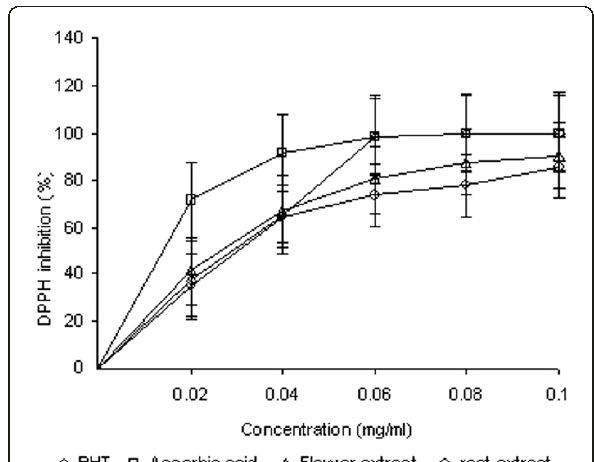
Figure 1 PPH scavenging activities of the methanolic extracts of the flowers and roots of P. venusta .